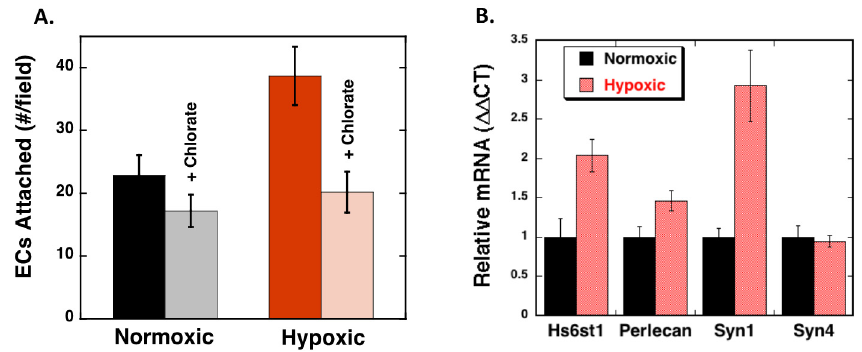
Figure 6. Hypoxia-mediated endothelial cell attachment correlates with increased HS proteoglycan expression. ( A ) RPE were seeded as described above and 50 mM sodium chlorate was added to the cell culture medium immediately prior to the onset of hypoxia. After 72 h, RECs were seeded onto the RPE cell layer and allowed to attach for 1 h and the counted (4 fields / well; 3 wells / condition; n = 4; N = 3). The data is expressed as the average number of cells per field ± SEM. ( B ) RPE cells were maintained under hypoxic (1% pO 2 ) or normoxic (20% pO 2 ) conditions for 72 h prior to total RNA extraction and mRNA quantitation using qPCR analyses. The data is normalized to the 18S RNA and to the normoxic control for each condition. The data is expressed as the average ± SEM ( N = 4; n = 2). Hypoxia significantly increased REC attachment to RPE cells and chlorate caused a significant ( p < 0.05) reduction in REC attachment to hypoxic cells, and hypoxia significantly increased expression of Hs6st1 and